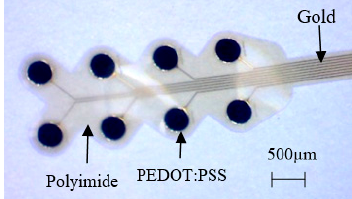
Figure 2. PEDOT:PSS coated test electrode